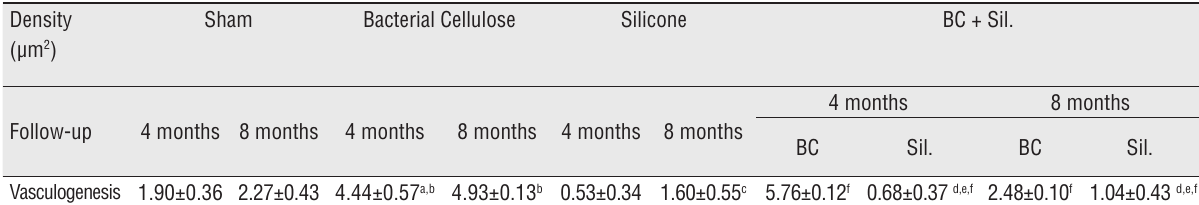
Table 2 - Density of Blood vessels in the implant area. Density Sham Bacterial Cellulose Silicone BC + Sil.